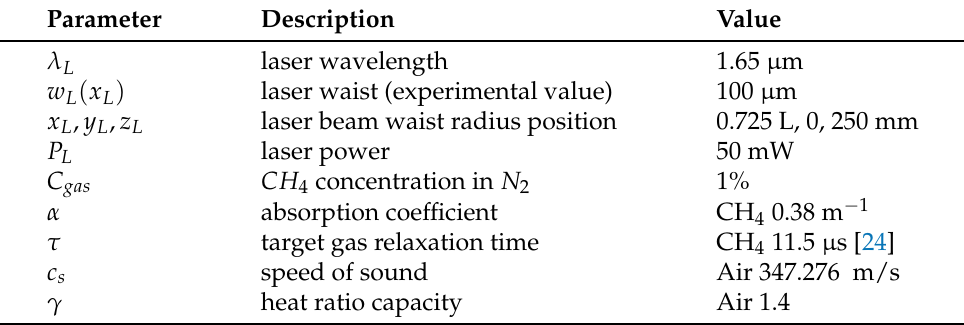
Table 2. Parameters used to describe the laser source and the acoustic